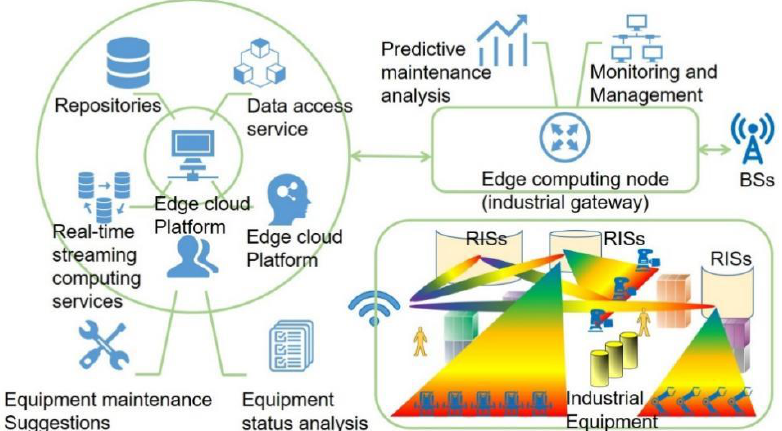
Figure 3. Shape-adaptive RIS-based innovative infrastructure for the intelligent industrial IoTs.